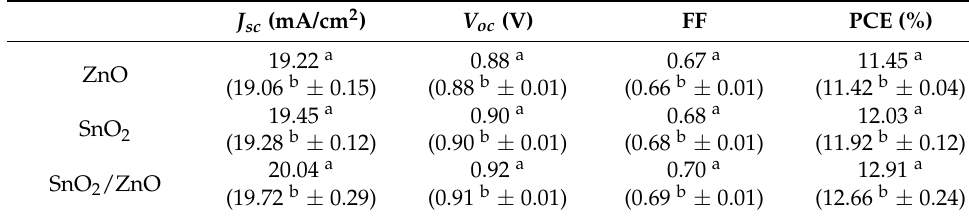
Table 1. Photovoltaic performance of devices with ZnO, SnO 2 and SnO 2 /ZnO films.